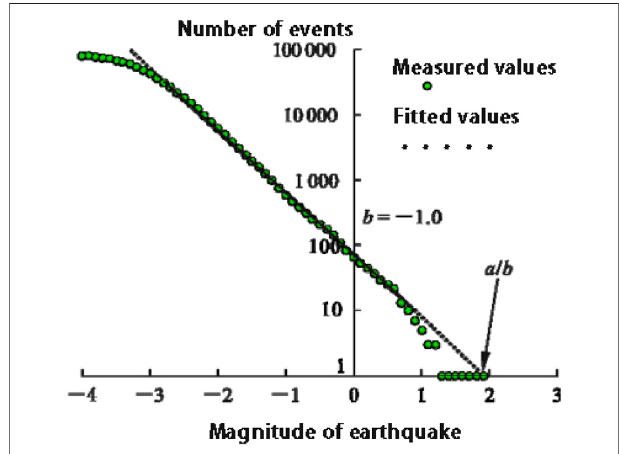
FIGURE 7 | A typical frequency-magnitude relation curve (Gibowicz and Lasocki, 1990).